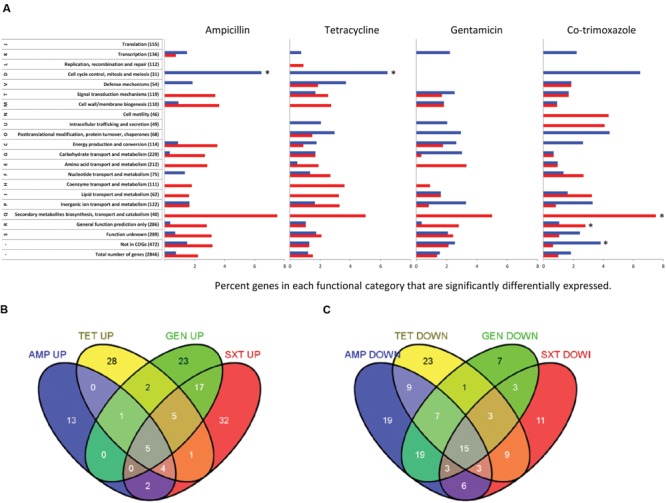
Listeria monocytogenes EGD genes differentially expressed when exposed to ampicillin, tetracycline, gentamicin, or co-trimoxazole. (A) Functional categories of differentially expressed genes in response to the four antibiotics. Genes that passed the statistical filtering (p < 0.05, q < 0.05 and a twofold cut-off) are shown as percentage of genes in each functional category up-regulated (blue) or down-regulated (red), respectively, when comparing antibiotic-exposed L. monocytogenes EGD with MilliQ control. The list of genes included in each functional category was based on cluster of orthologous groups (COGs) of L. monocytogenes EGD-e genes (http://www.ncbi.nlm.nih.gov/sutils/coxik.cgi?gi=204%25253e). Asterisk indicate that the functional category was overrepresented in a hypergeometric distribution test (p = 0.01). (B) Venn diagram with up-regulated genes showing antibiotic-specific and common genes significantly differentially expressed genes. (C) Venn diagram with down-regulated genes showing antibiotic-specific and common genes significantly differentially expressed genes. Ampicillin (AMP), tetracycline (TET), gentamicin (GEN), and co-trimoxazole (SXT).